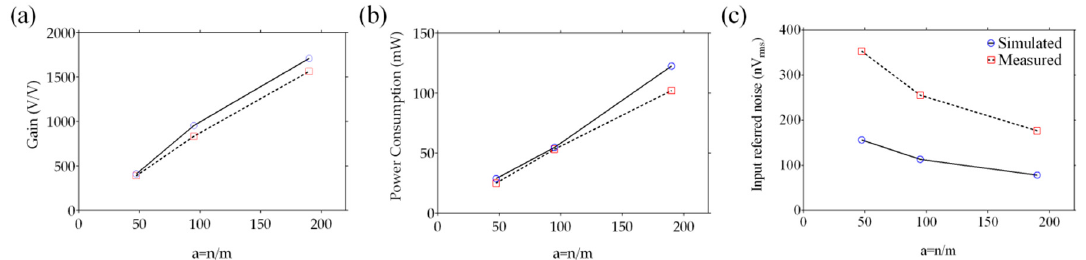
Figure 7. Simulated and experimental characteristics of the designed EGFETs: ( a ) voltage gain, ( b ) power consumption, and ( c ) input referred noise. ( b ) power consumption, and ( c ) input referred